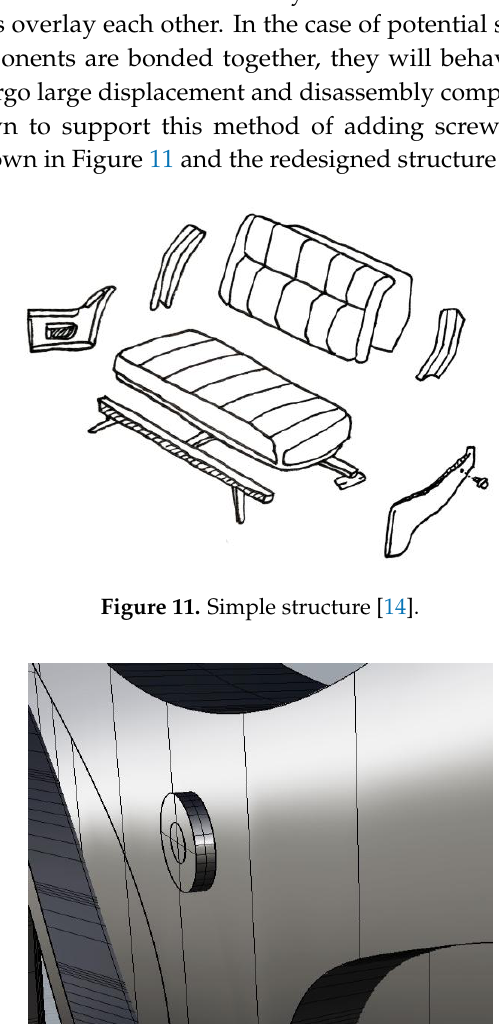
Figure 10. Redesigned structure.